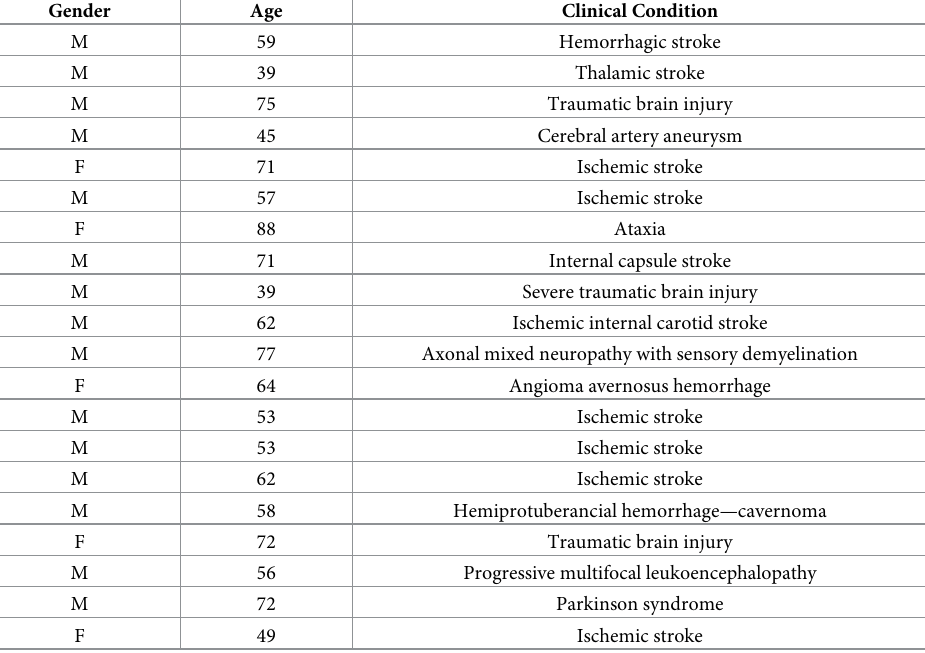
Table 1. Socio-demographic and clinical characteristics of patients from Lescer Clinic by gender, age and clinical